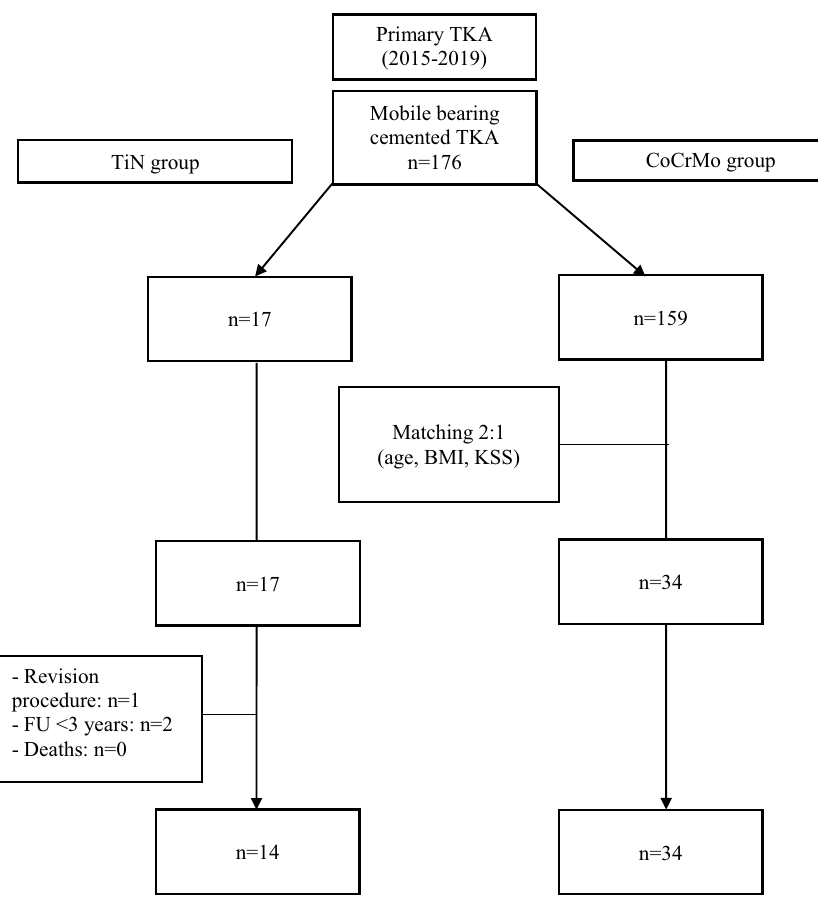
Figure 2. Flowchart of the